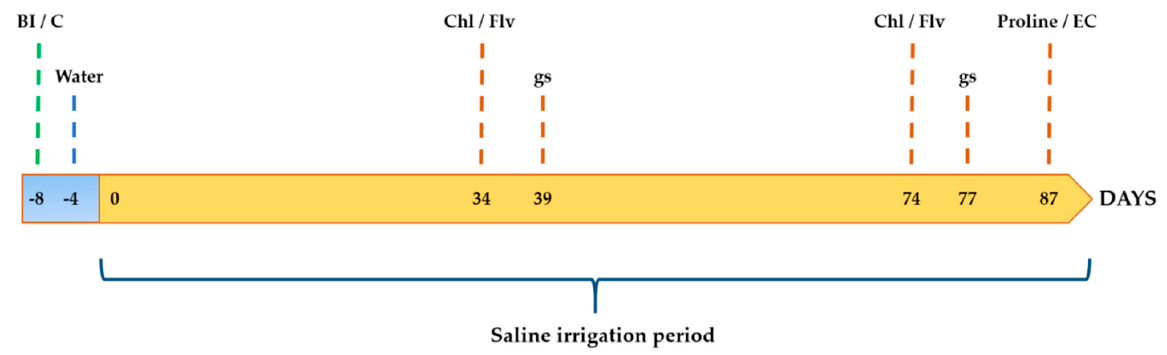
Figure 1. Schedule of activities performed during a salt stress experiment. Bacterial inoculation (BI) or 10 mM MgSO 4 · 7H 2 O irrigation of control (C) plants is shown by a green discontinuous line (T = − 8 days). Water irrigation is shown by a blue discontinuous line (T = − 4 days). At time T = 0 days plants received the first dose of the salt solution. Subsequent saline doses or distilled water were applied every two or three days until the end of the experiment (87 days) (see text for details). The different physiological/biochemical parameters evaluated are shown with discontinuous brown lines. Chl, chlorophyll; EC, electrical conductivity; Flv, flavonoids; gs, stomatal conductance. This experiment was performed twice.